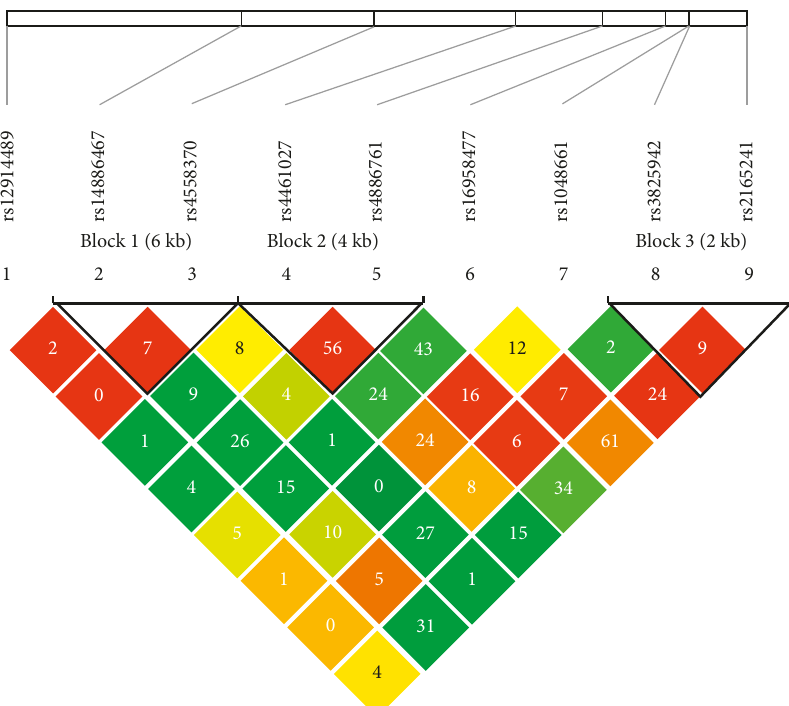
Figure 1: Haploview analysis block diagram of